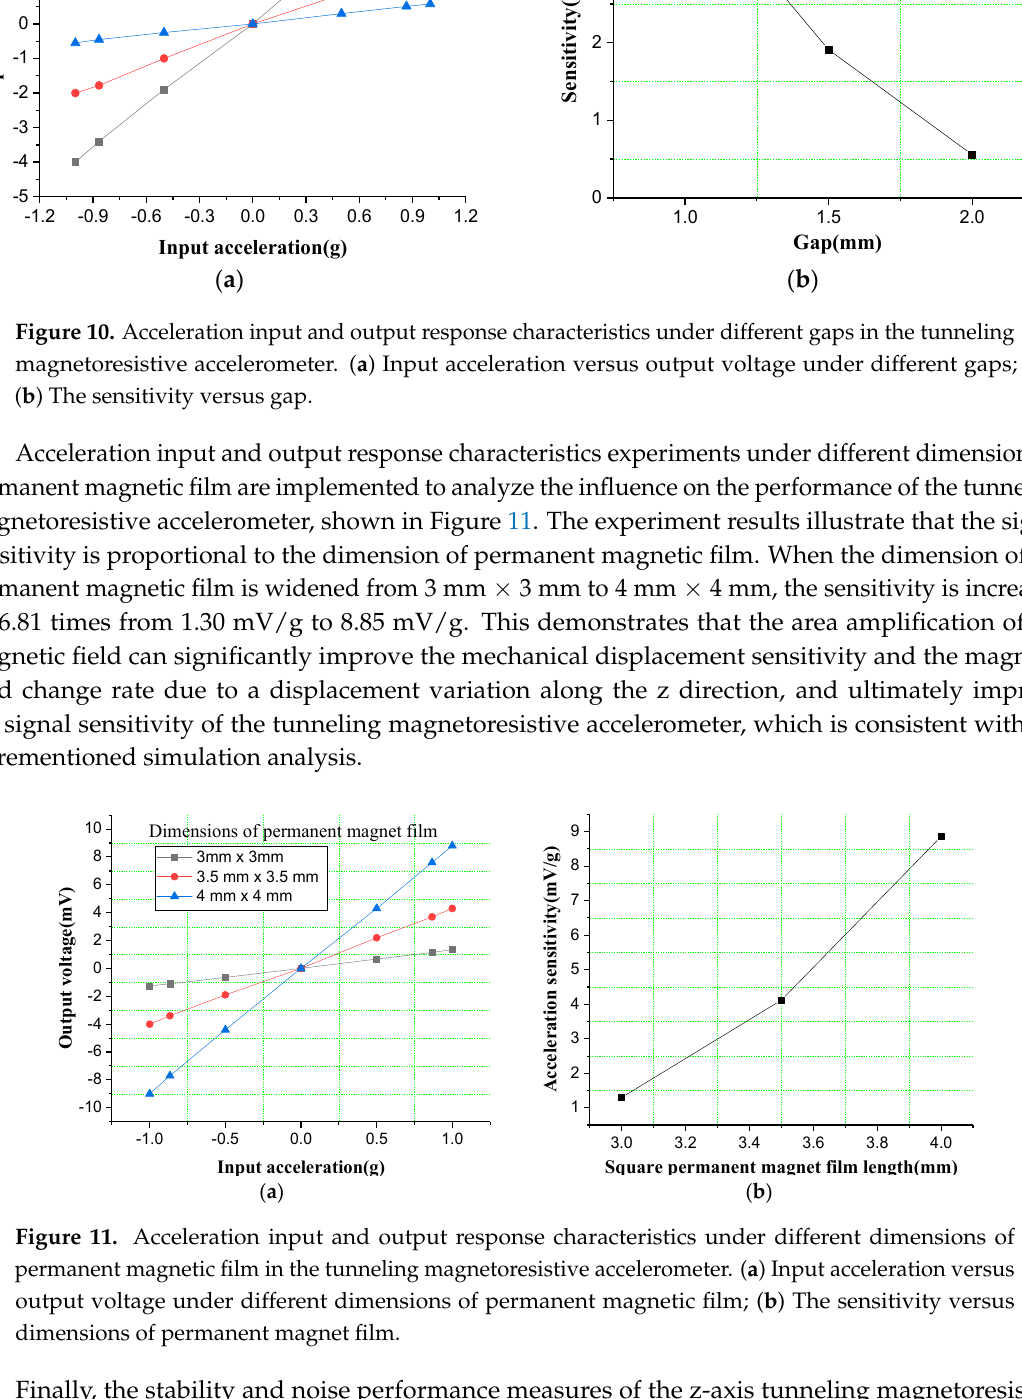
( b ) ( c ) Figure 9. The optical micrograph of micromachined z-axis tunnel magnetoresistive accelerometer. ( a ) The plane main structure of tunnel magnetoresistive accelerometer; ( b ) Commercial tunnel magnetoresistive sensor; ( c ) Micro-assembled overall structure. In order to fully evaluate the performance of tunnel magnetoresistive accelerometers, system experiments under various conditions are implemented. We test the acceleration input and output response characteristics under different gaps in the tunneling magnetoresistive accelerometer, shown in Figure 10. The experiment results demonstrate that the signal sensitivity is inversely proportional